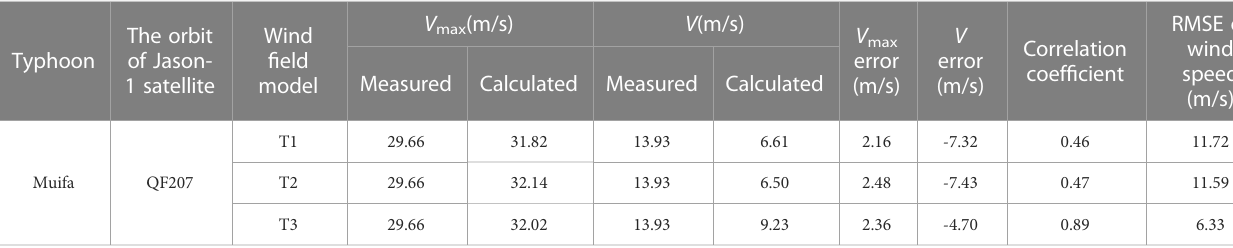
TABLE 2 Wind speed simulation and Jason-1 satellite measured value.